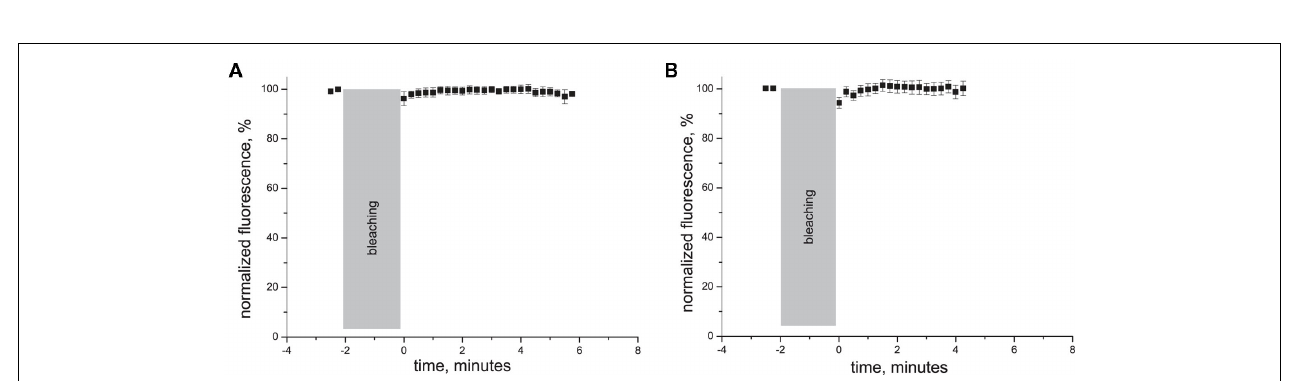
FIGUREA2 |Traces of normalized fluorescence recovery in experiments on hippocampal neurons transfected with plasmid encoding for cytoplasmic DsRed in soma (A) and dendrites (B).